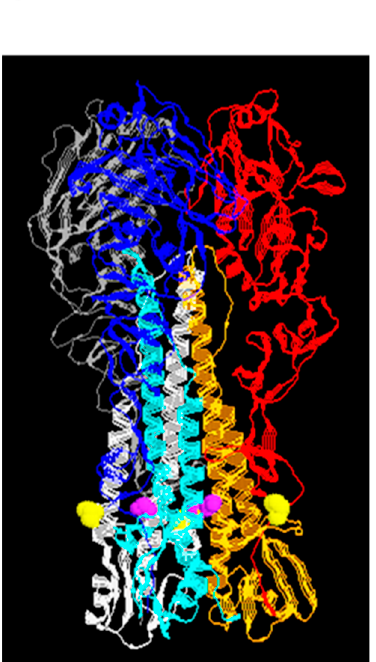
Figure 3. X-ray crystal structure of the HA trimer from the influenza virus A type H5. Each HA monomer is divided into HA 1 (red, blue, and gray) and HA 2 (oarange, cyan, and white, respectively) subunits after the PC cleavage denoted by residues at the end HA 1 (yellow) and the beginning of HA 2 (purple). PDB ID code 2IBX.